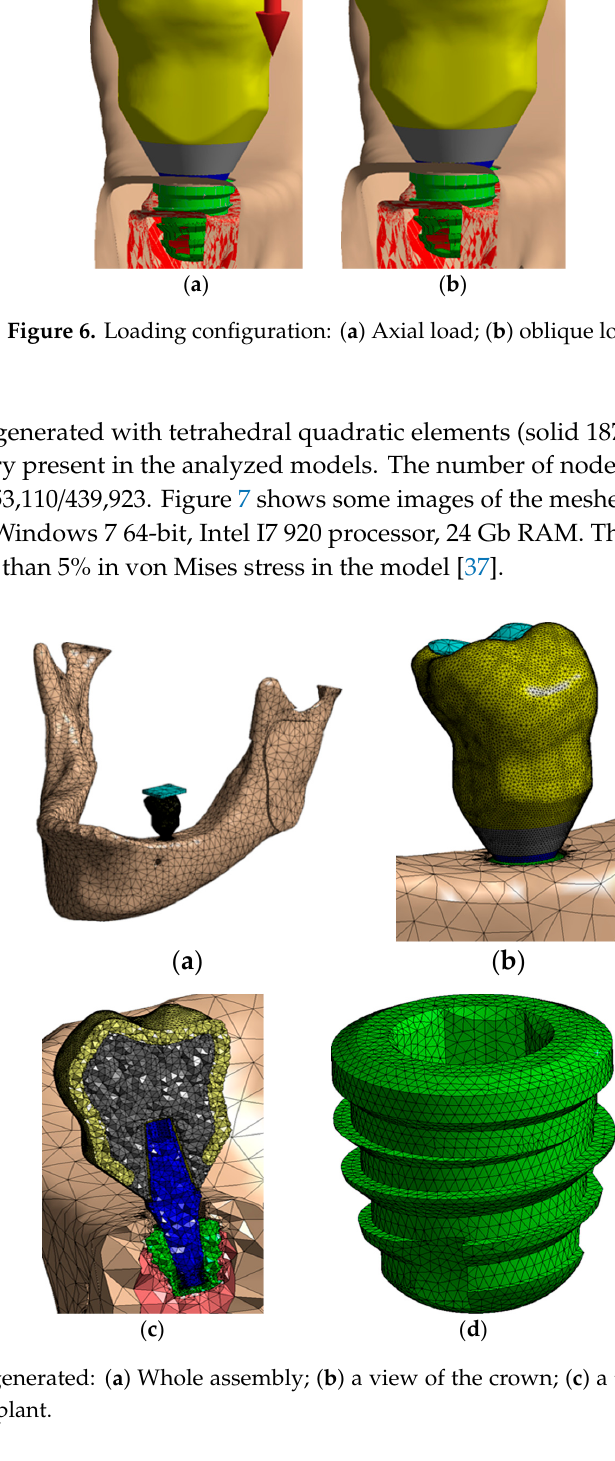
( f ) Figure 8. von Mises stress distribution in MPa: ( a ) IH vestibular view; ( b ) IH distal view; ( c ) IH stress concentration; ( d ) MT vestibular view; ( e ) MT distal view; ( f ) MT stress concentration. Stress concentrations on the IH implant are observed in the region of the first threads for the screw (Figure 8c). However, in the MT implant the highest stress occurs at the edges of the upper implant platform (Figure 8f). Regarding the IH extra-short implant, the internal hexagon is not employed to dissipate the stress caused by the load. In this case, stresses are dissipated through the internal threads of the implant, the implant-to-screw contact region, and the intermediate-implant contact region. However, the MT extra-short implant obtained a favorable and homogenous distribution along the